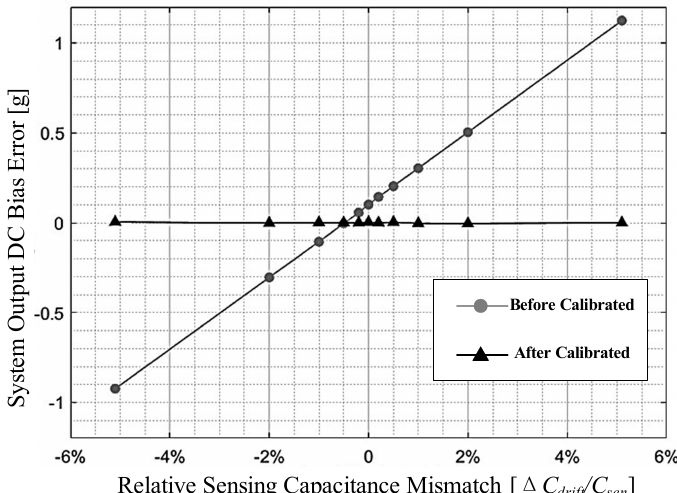
Figure 9. System output DC bias error with respect to the mismatch in sensing capacitances. Bias instability performance is tested at room temperature, and the output of the digital closed − loop MEMS accelerometer is recorded for about 4 h, as shown in Figure 10. The bias instability after the calibration is about 18 µg.